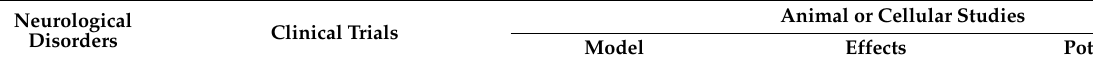
Table 1. Effects of metformin on neurological